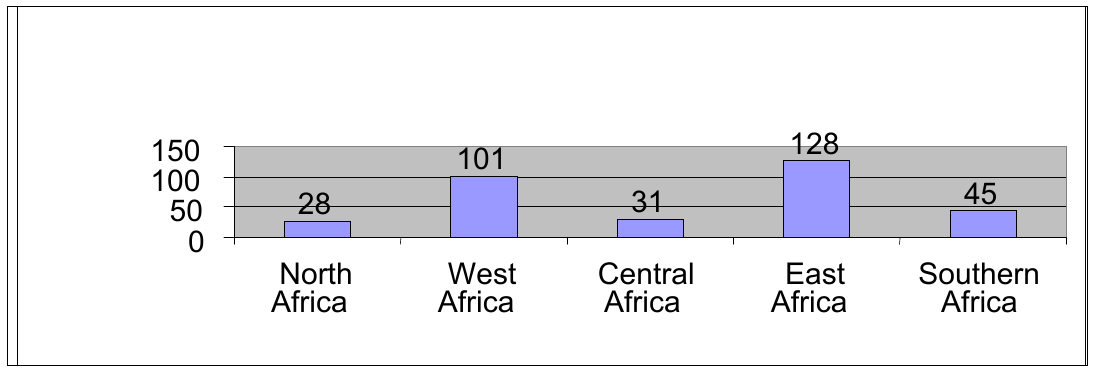
Figure 4: Drought hazards in Africa: 1974 to 2003